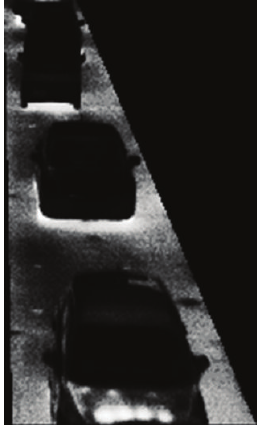
Figure 12: An image in lane 2 after final optimum gamma transfor-